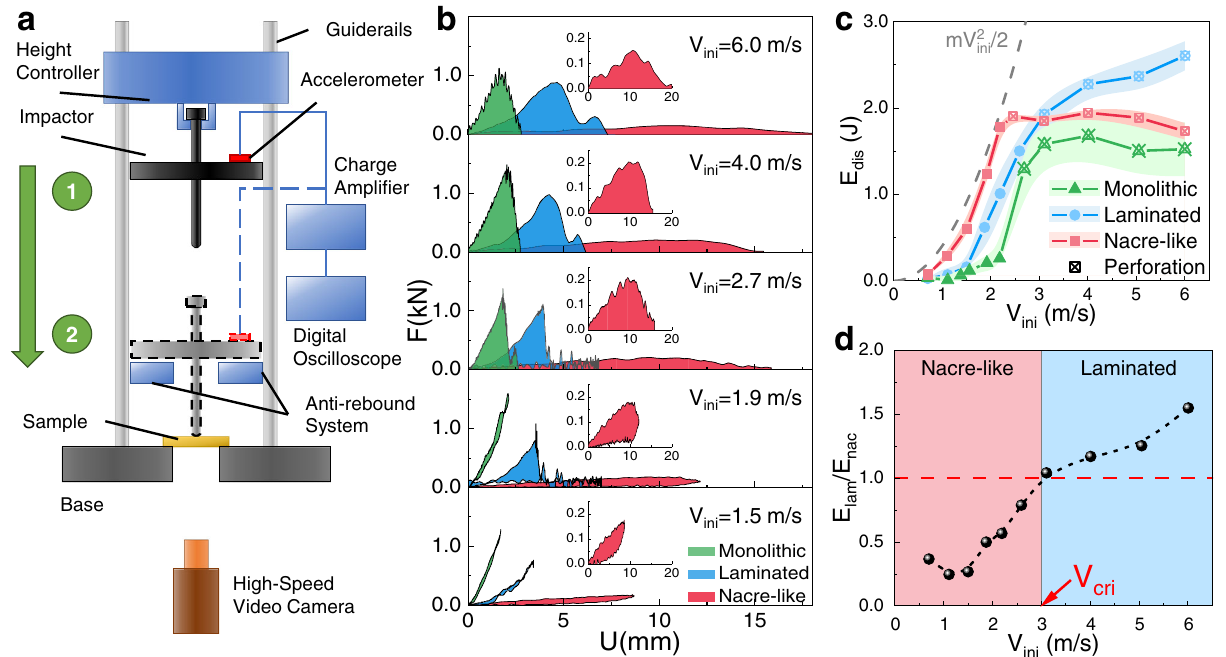
Fig. 2 | Impact resistance of the nacre-like structure under different impact velocities. a Schematic of the drop-tower test system equipped with a high-speed camera. b Theforce F -displacement U curvesofthemonolithicsamples,laminated samples, and nacre-like samples under different impact velocities V ini . The insets show magni fi ed views for force-displacement curves of the nacre-like samples.